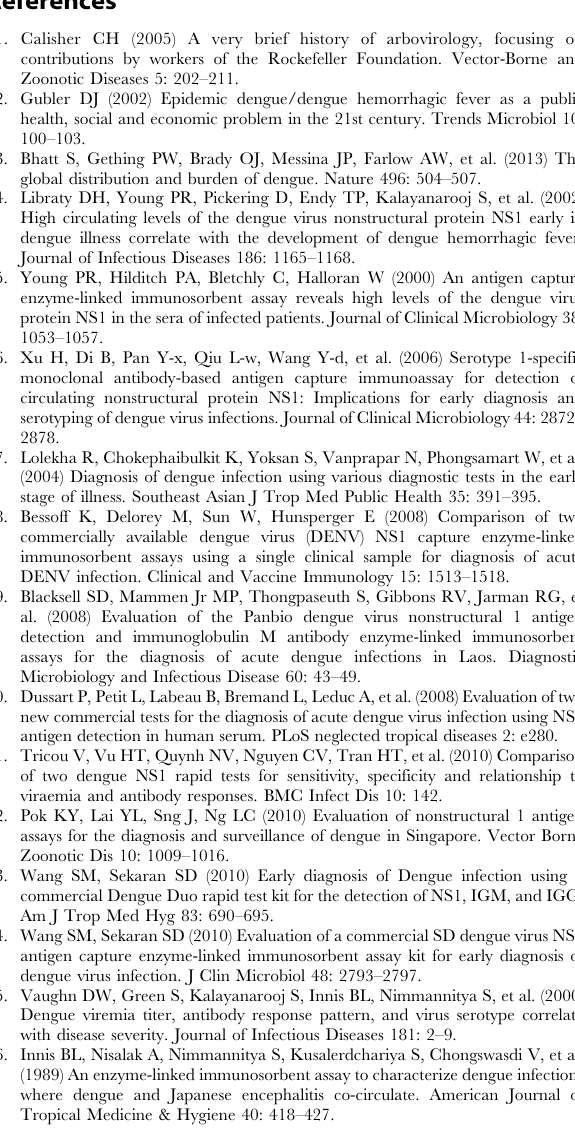
Table S1 Number of dengue virus (DENV) positive specimens in the non-structural protein 1 (NS1) panel (Table 1) by infection status (primary vs. secondary DENV infection) and days post onset of fever (DPO). Table S2 Commercial test characteristics of: A) NS1 ELISAs B) NS1 rapid diagnostic tests (RDTs) C) anti-DENV IgM ELISA and D) anti-DENV IgM